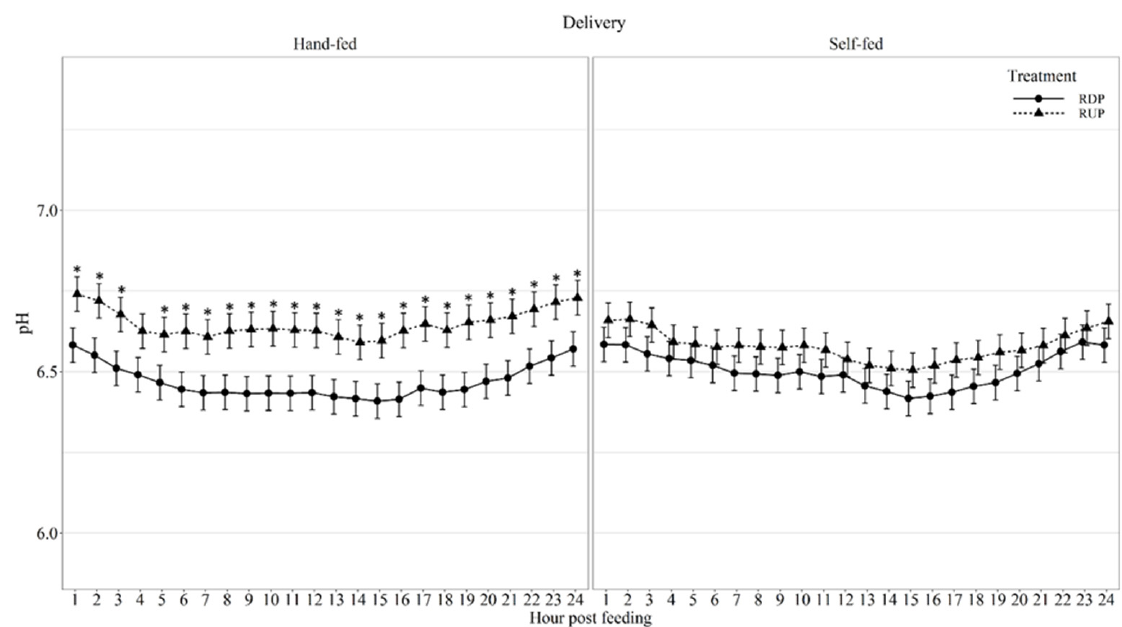
Figure 2. Diurnal ruminal pH patterns of beef cows fed hand-fed or self-fed rumen degradable (RDP) or rumen undegradable (RUP) protein supplements with low-quality forage at 08:00. Ruminal pH was influenced by delivery method × protein type × hour post-feeding interaction ( p < 0.01), and differences ( p ≤ 0.05) within hour post-feeding are denoted by *.